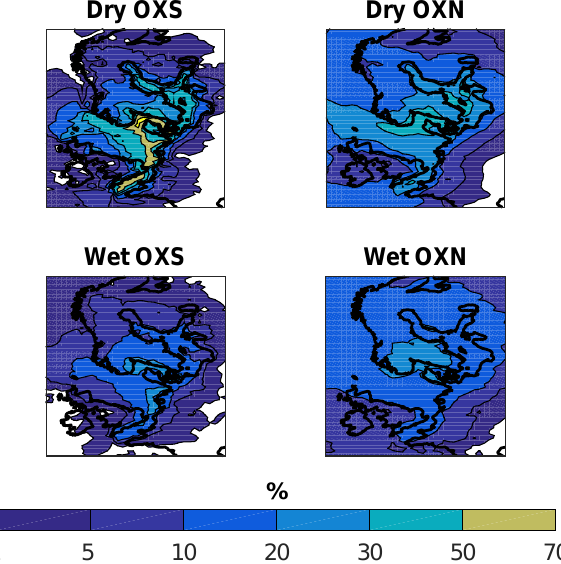
Figure 17. Percentage (%) of the deposition caused by international shipping in the Baltic Sea and the North Sea in 2013 of (a) dry OXN, (b) dry OXS, (c) wet OXN, and (d) wet